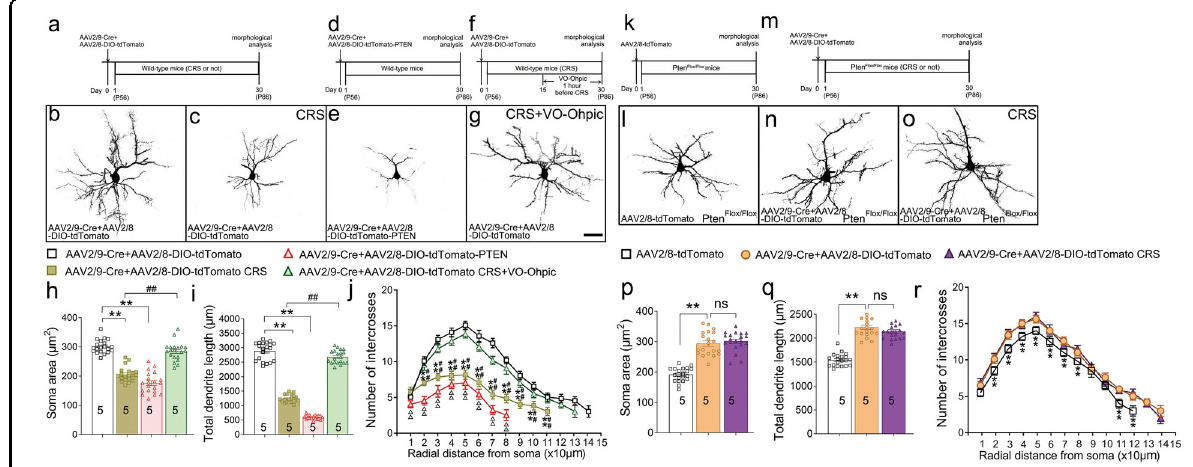
Fig. 4 PTEN is a key factor involved in the CRS-induced dendrite atrophy. a Diagram of experiment design and timeline for ( b , c ). b , c Representative images showing the dendrite tree of pyramidal neurons in layers II/III of PFC from control mice and CRS-treated mice. d Diagram of experiment design and timeline for ( e ). e Representative image showing the dendrite tree of pyramidal neurons in layers II/III of PFC from mice with over-expression of Pten . f Diagram of experiment design and timeline for ( g ). g Representative image showing the dendrite tree of pyramidal neurons in layers II/III of PFC from CRS-treated mice with VO-Ohpic administration. h – j Statistical data showing the soma size ( h ), total length of dendrites ( i ), and dendritic branching ( j ) of the PFC neurons in indicated groups. n = 20 cells from 5 mice in each group and all data are presented as mean ± SEM. One-way ANOVA ( h , i ), ** p < 0. 01 versus controls, ## p < 0.01 (CRS-treated mice versus CRS-treated mice with VO-Ohpic). Two-way ANOVA with post hoc Tukey ’ s test ( j ), * p < 0. 05, ** p < 0.01 (control mice versus CRS-treated mice); # p < 0.05, ## p < 0.01 (CRS-treated mice versus CRS- treated mice with VO-Ohpic); Δ p < 0. 05; ΔΔ p < 0. 01 (control mice versus mice with over-expression of Pten ). k Diagram of experiment design and timeline for ( l ). l Representative image showing the dendrite tree of pyramidal neuron in layers II/III of PFC from control mice. m Diagram of experiment design and timeline for ( n , o ). n , o Representative images showing the dendrite tree of pyramidal neuron in layers II/III of PFC from Pten - de fi cient neurons without or with CRS, respectively. Deletion of Pten was achieved by the injection of AAV2/9-Cre in Pten Flox/Flox mice. p – r Statistical data showing the soma size ( p ), total length of dendrites ( q ), and dendritic branching ( r ) of the PFC neurons in indicated groups. n = 20 cells from 5 mice in each group and all data are presented as mean ± SEM. One-way ANOVA ( p , q ), ** p < 0. 01 versus controls. Two-way ANOVA with post hoc Tukey ’ s test ( r ), * p < 0. 05, ** p < 0.01 (control neuron versus Pten -de fi cient neurons with CRS). Scale bar = 40 μ m ( b , c , e , g , l , n , and o ). CRS, chronic restraint stress; VO-Ohpic, VO-Ohpic